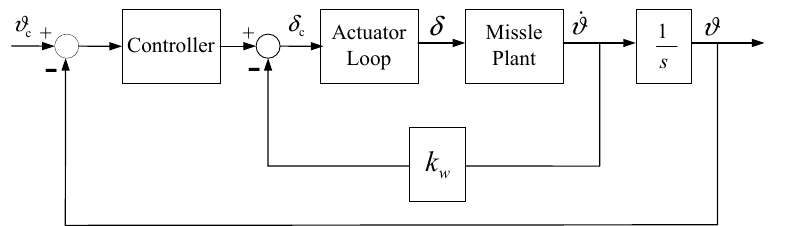
Figure 5. Block diagram of longitudinal attitude control.